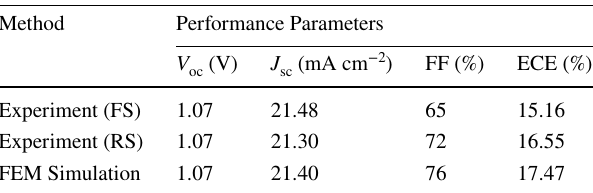
Table 1 A comparison between experiment and simulation for pho‑ tovoltaic performance parameters extracted from J-V characteristics of planar PSCs, as shown in Fig. 2d